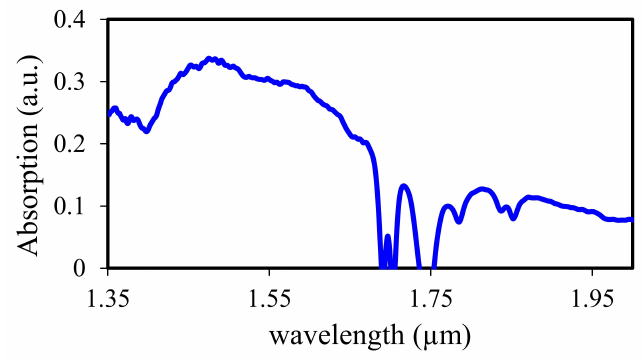
Figure 1. Absorption spectrum of carbon